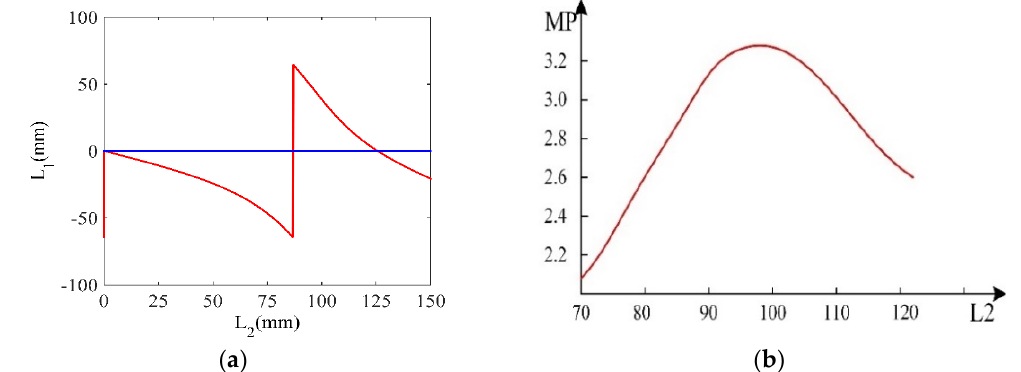
Table 3. 2 stage horn parameters. Figure 1. Schematic diagram of the horn.